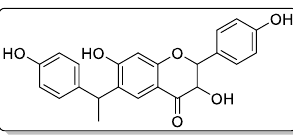
Figure 7. This is chemical formula of the compound 1 (Figure 4).